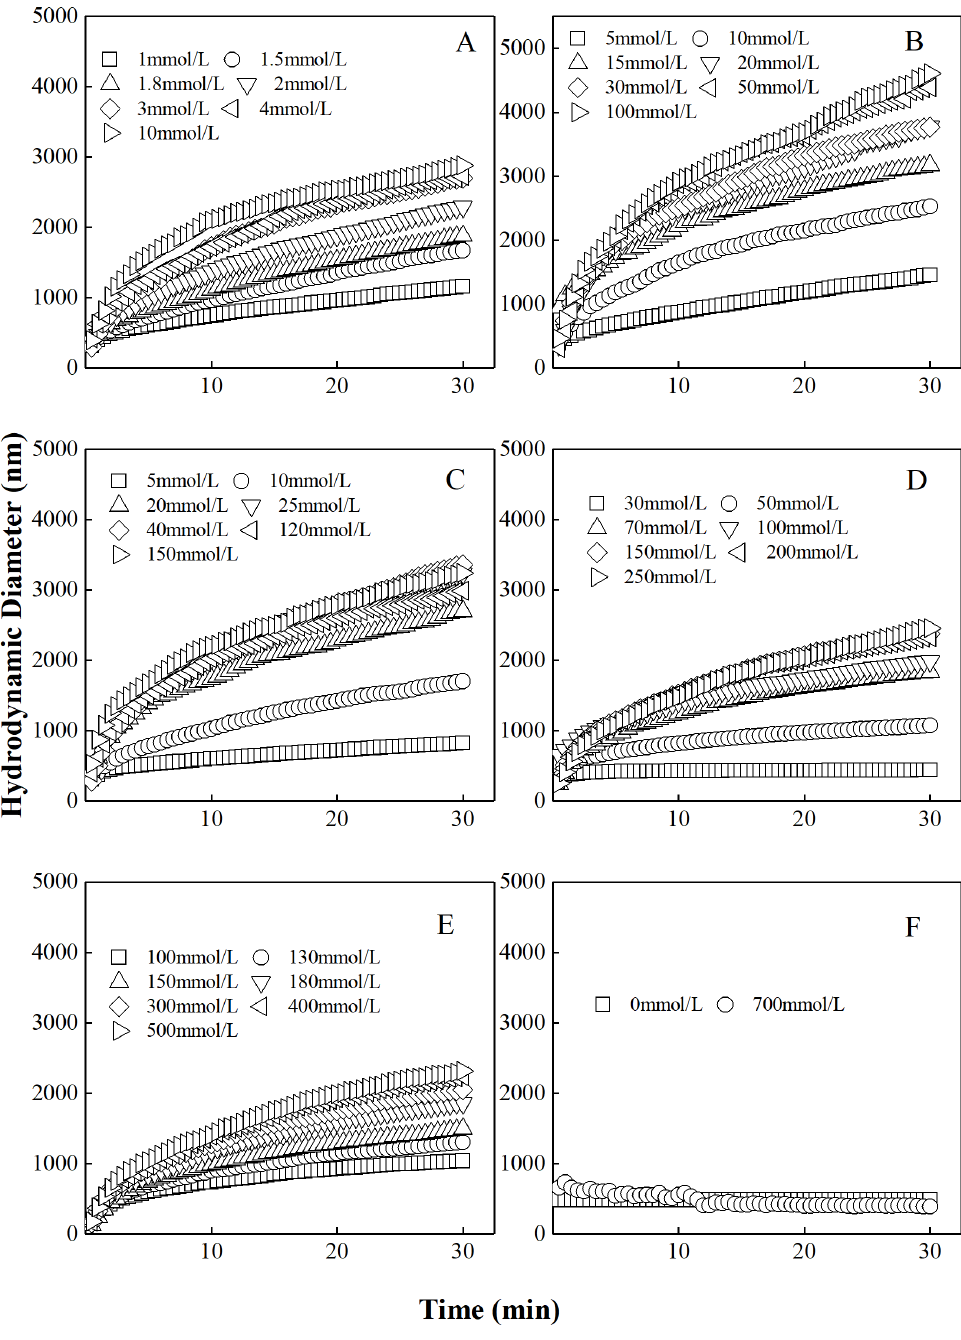
Figure 2 Growth of hydrodynamic diameters of ‘‘100%kaolinite (A), 96.67% kaolinite + 3.33% P. putida (B), 93.33% kaolinite + 6.67% P. putida (C), 83.33% kaolinite + 16.67% P. putida (D), 66.67% kaolinite + 33.33% P. putida (E), 100% P. putida (F)" aggregates in KNO 3 solutions. Full-size DOI: 10.7717/peerjpchem.12/fig-2